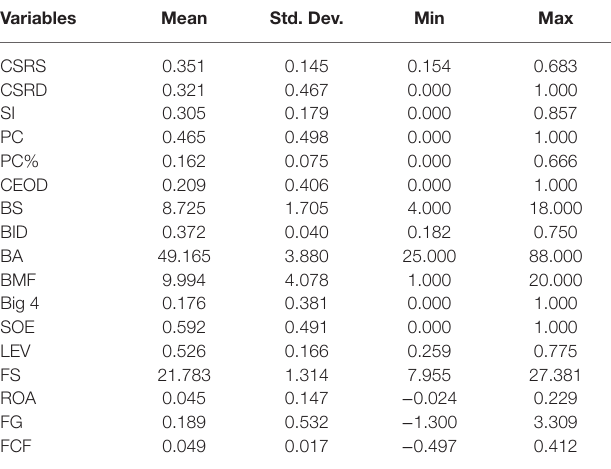
TABLE 2 | Descriptive statistics.